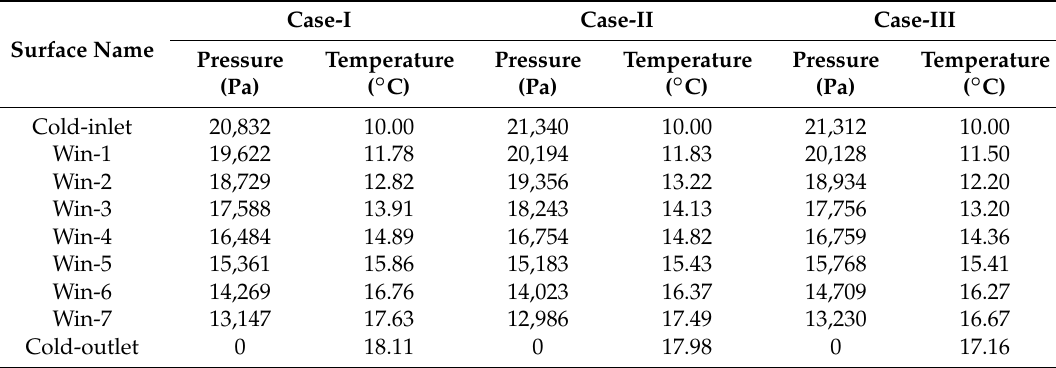
Table 4. Computed temperature and pressure values at different surfaces